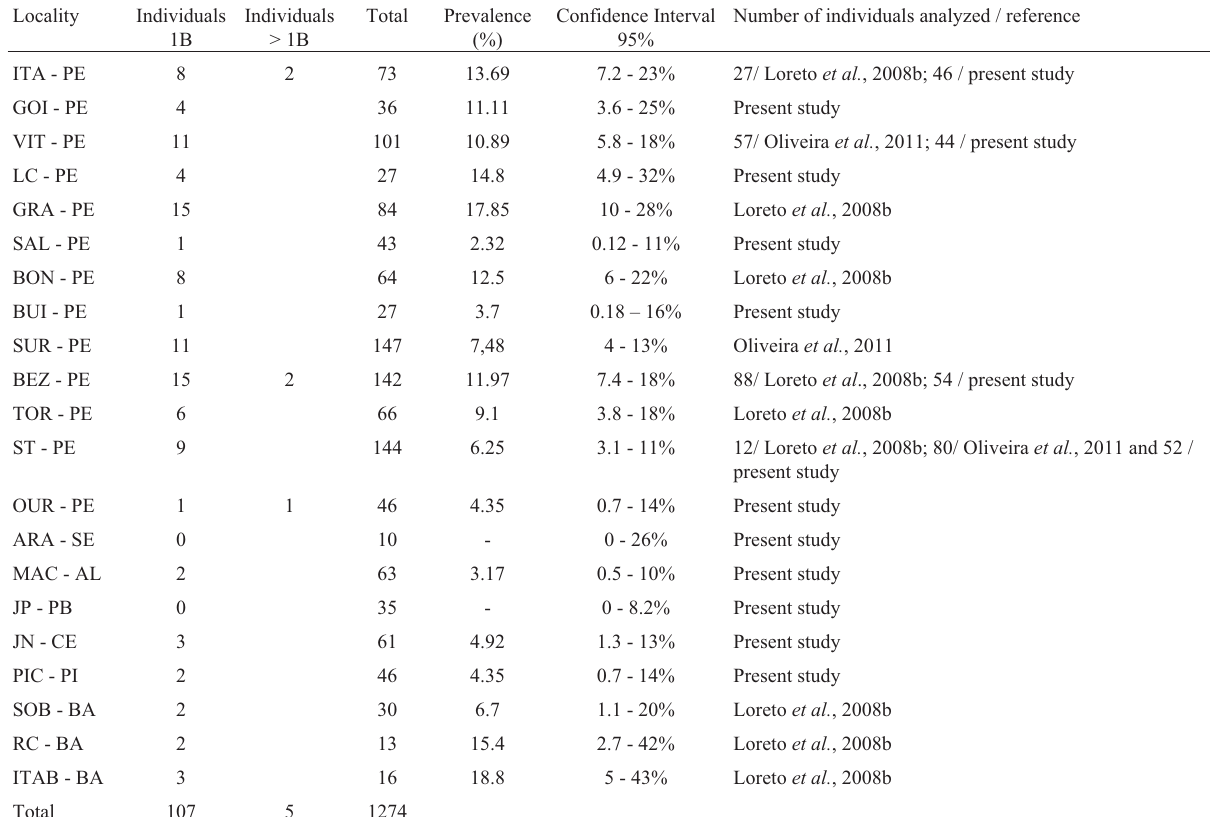
Table 2 - Occurrence, distribution, frequency and confidence interval of B chromosomes in the analyzed populations of Rhammatocerus brasiliensis in the Northeast of Brazil.